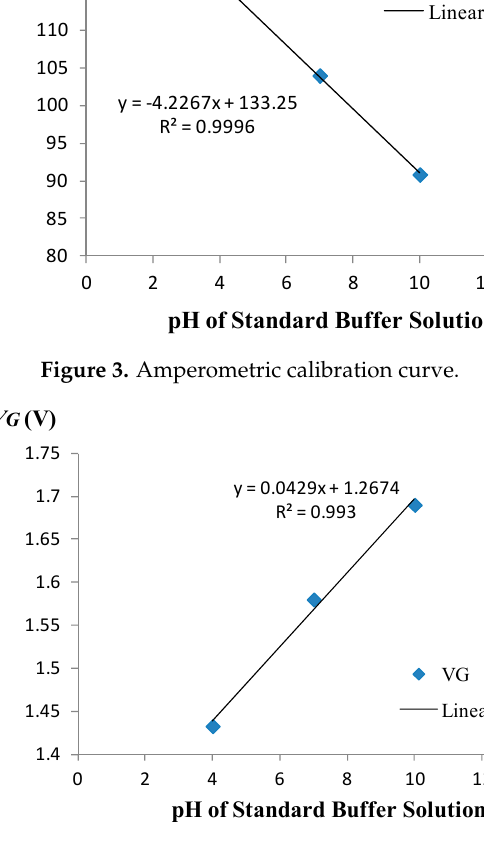
Figure 4. Feedback-mode calibration curve.